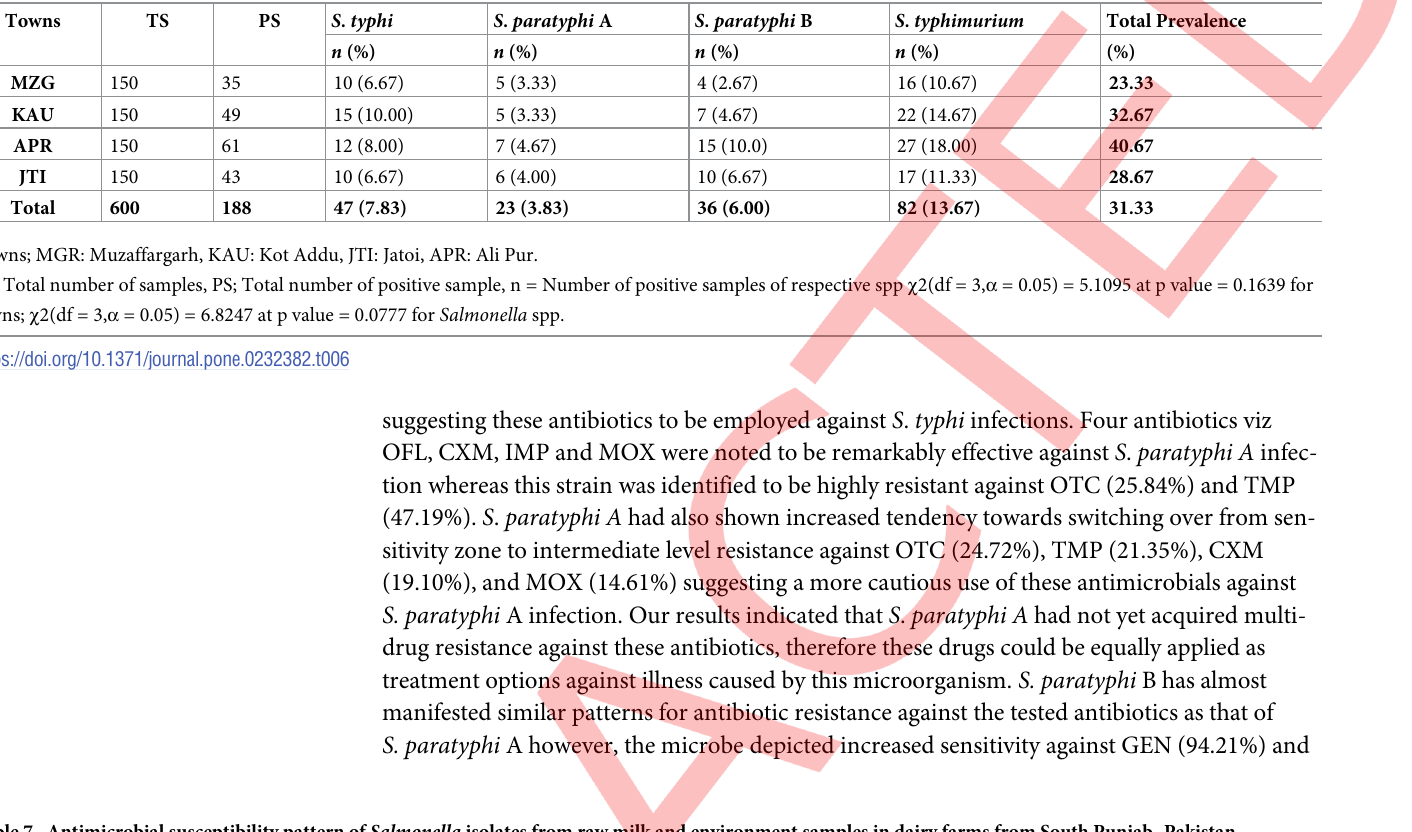
Table 7. Antimicrobial susceptibility pattern of Salmonella isolates from raw milk and environment samples in dairy farms from South Punjab- Pakistan. Antibiotic ( μ g) S . typhi n